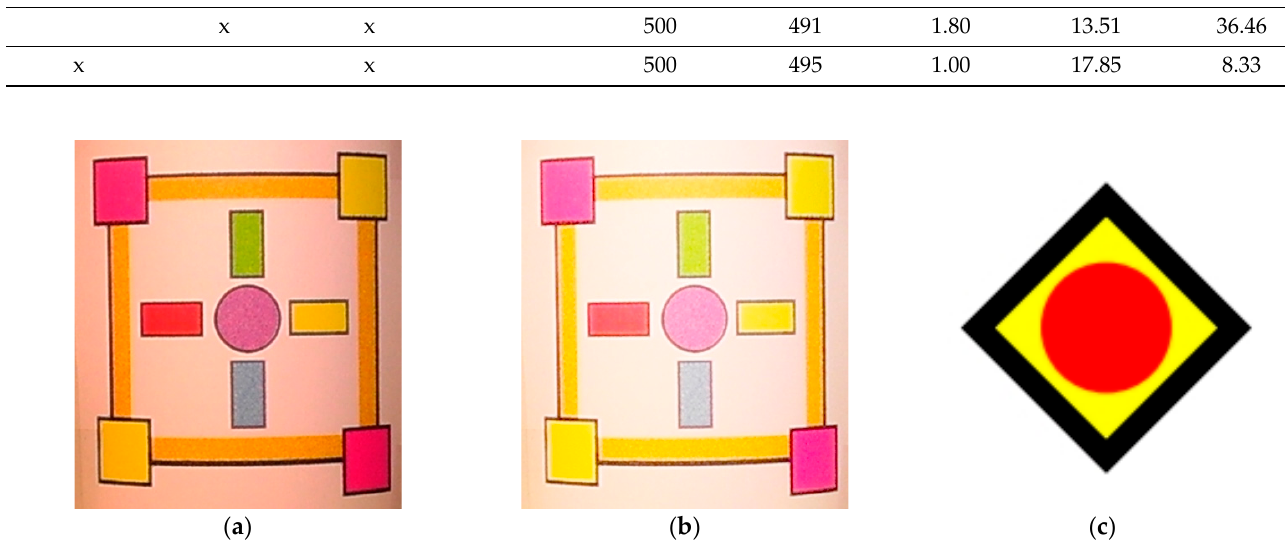
Figure 13. Dynamic simulation of robot arm motion. ( a ) Home position of robot arm; ( b ) position near target.